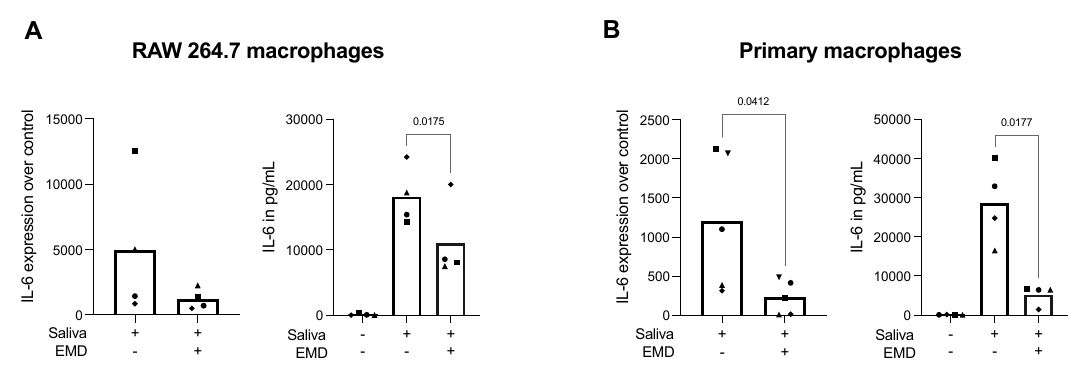
Figure 1. Gene expression of IL-6 and IL-6 immunoassay in RAW 264.7 cells ( A ) and primary macrophages ( B ) under 5% saliva stimulation. EMD diminished the elevated IL-6 expression and secretion after saliva challenge in RAW 264.7 cells and primary macrophages. Each data point represents an independent experiment. To compare groups, paired t -tests were applied, and the statistically significant p values were added to graphs.